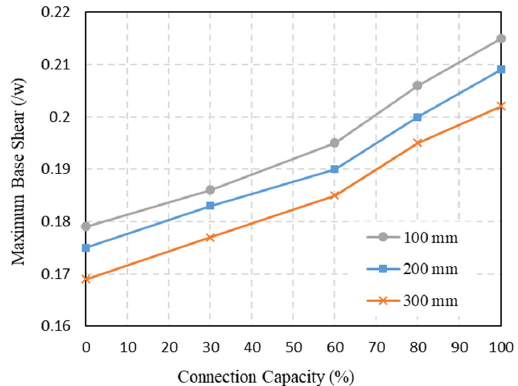
Figure 26. Maximum base shear of 5-story frame subjected to 5 earthquake records.